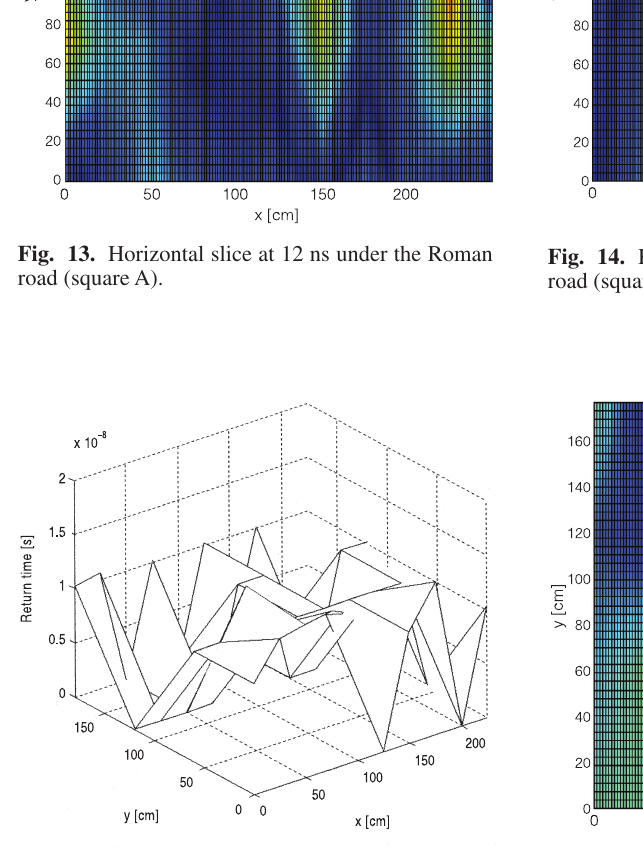
Fig. 15. Planar interpolation of the meaningful return times outside the theatre area (square C).